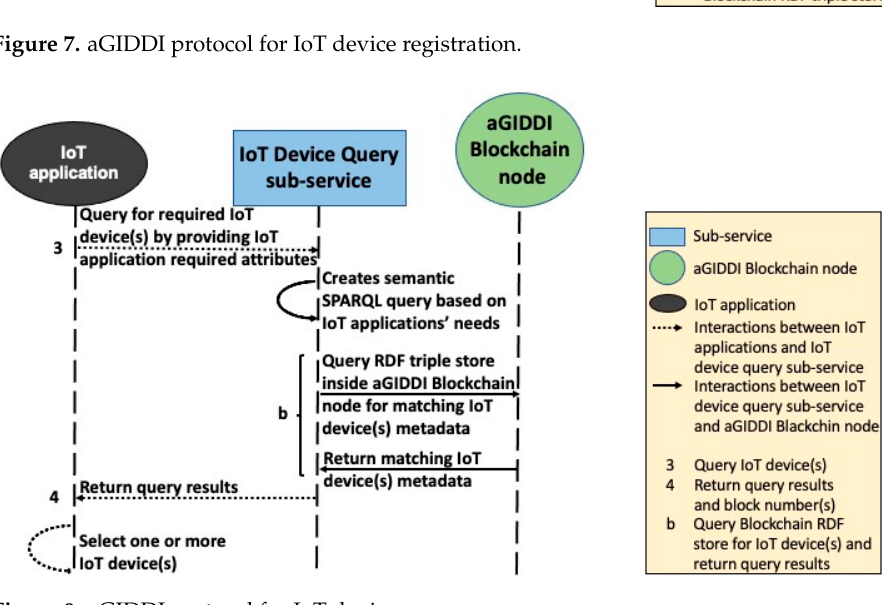
Figure 8. aGIDDI protocol for IoT device query.